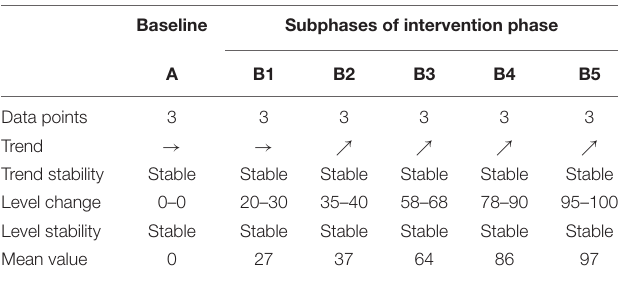
TABLE 2 | Functional communication vocabulary recognition (individual